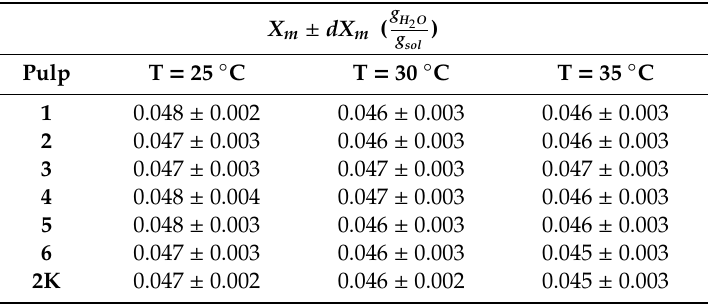
Table 3. Monolayer capacity values at 25, 30, and 35 ◦ C.